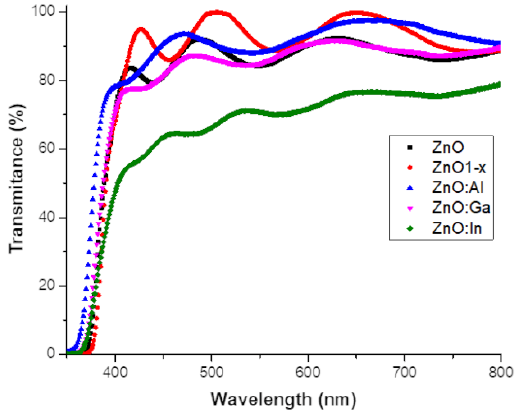
Figure 4. Transmittance spectra of ZnO doped and undoped thin films.